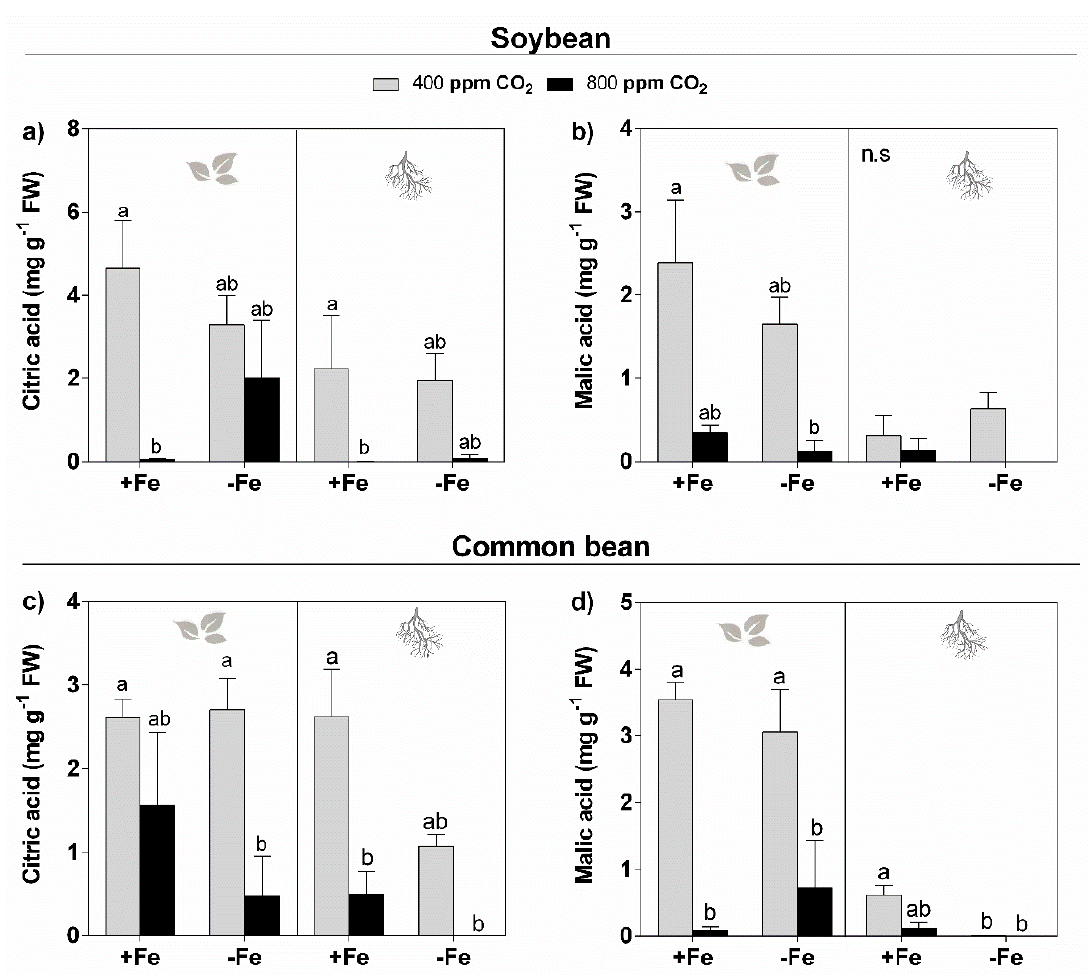
Figure 3. Concentrations of citric ( a , c ) and malic ( b , d ) acids in the leaves and roots of soybean and common bean plants grown at 400 ppm and 800 ppm CO 2 and with 0 ( − Fe) and 20 µ M Fe-EDDHA (+Fe). The results represent the mean of five biological replicates ± SE. Different letters above bars indicate significant differences p < 0.05 using the Tukey test. In common bean, under − Fe/aCO 2, citric acid was reduced 59% ( p < 0.1) and malic acid by 99% ( p < 0.05) in the roots but not in the leaves (Figure 3c,d). In addition,